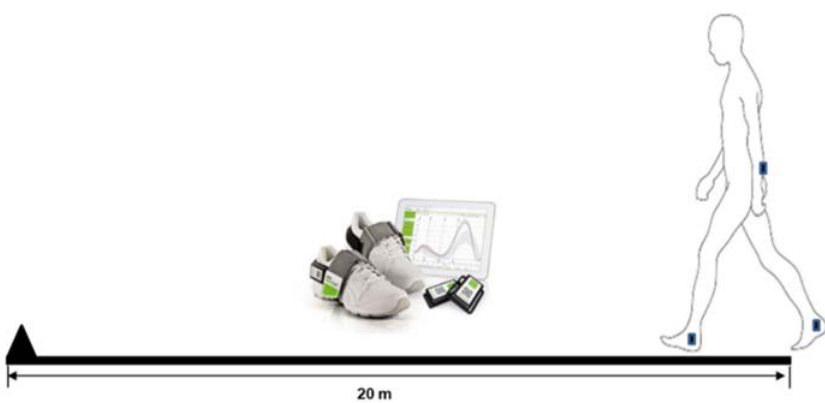
Figure 1. Protocol for gait assessment in the neurology ward.